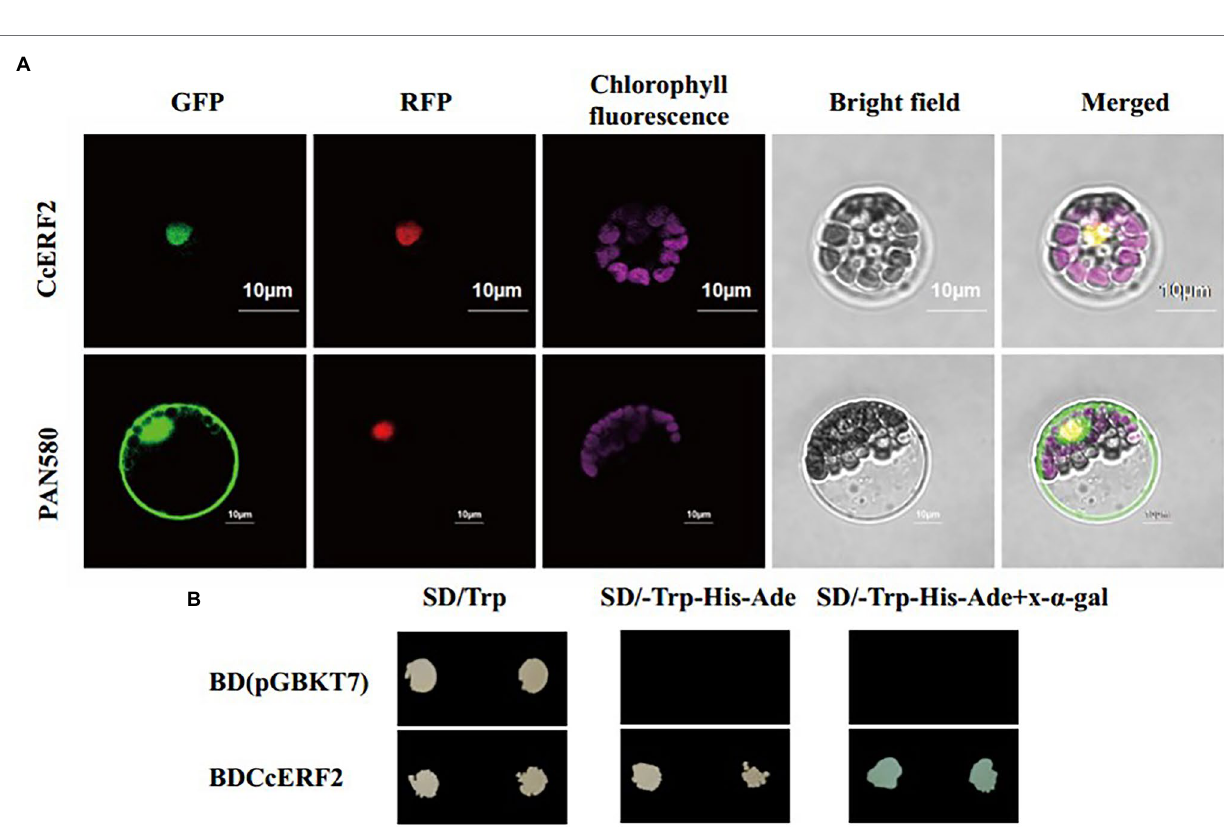
FIGURE 4 | Subcellular localization and transcriptional activation analysis. (A) Green fluorescent protein (GFP) signals indicated that CcERF2 was localized to nucleus. GFP fluorescence signals were detected using a Zeiss lsm710 confocal laser scanning microscope (Carl Zeiss, Inc., Jena, Germany). Scale bars: 10 μ m. (B) Auxotroph plates of SD/–Leu–His–Ade (middle) and SD/–Leu–His–Ade–x- α -gal (right) showing transcriptional activation of protein. SD/Trp, medium lacking tryptophan; SD/-Trp-His-Ade, medium lacking tryptophan, histidine, and